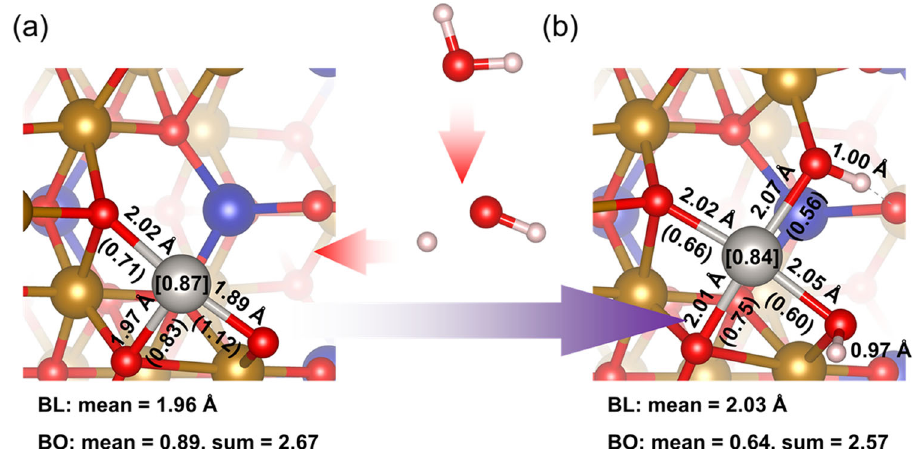
Fig. 4 The structure decoration around Pt single atoms. a Structure before water treatment, Pt/CF(110). b Structure after water treatment, Pt/CF(110)- W. BL: Pt-O or O-H bond length, BO (numbers in parentheses): Pt-O bond order. BL and BO are quoted beside the bond they belong to, numbers in square brackets are Bader charges of Pt atoms. Colors of atoms: H: white, O: red, Fe: brown, Co: blue,